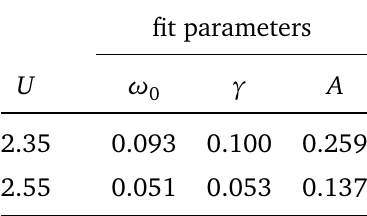
Table 1: Fit-parameters of χ th